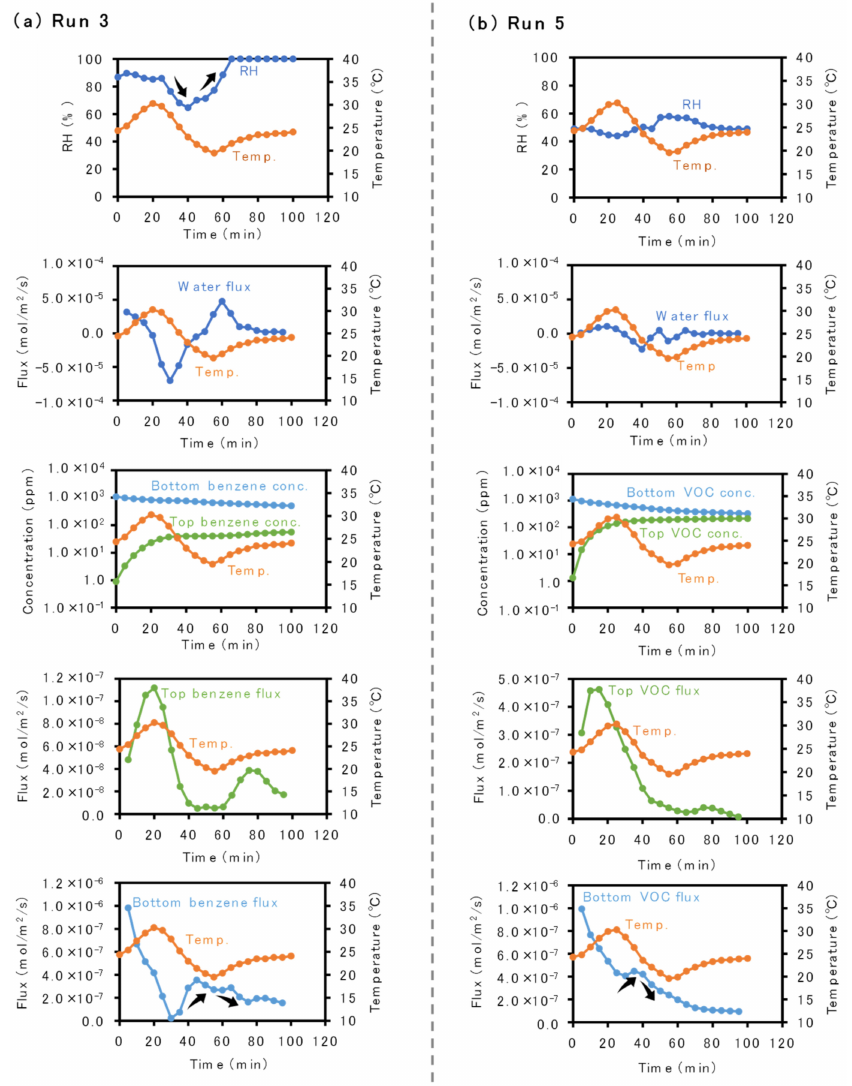
Figure 7. Changes in RH and corresponding water flux, top and bottom benzene concentrations, and corresponding top and bottom benzene fluxes in the dynamic temperature experiments Run 3 and Run 5, respectively, using finer-grained silica sand ( a ) at 10 wt% water content and ( b ) under air-dried